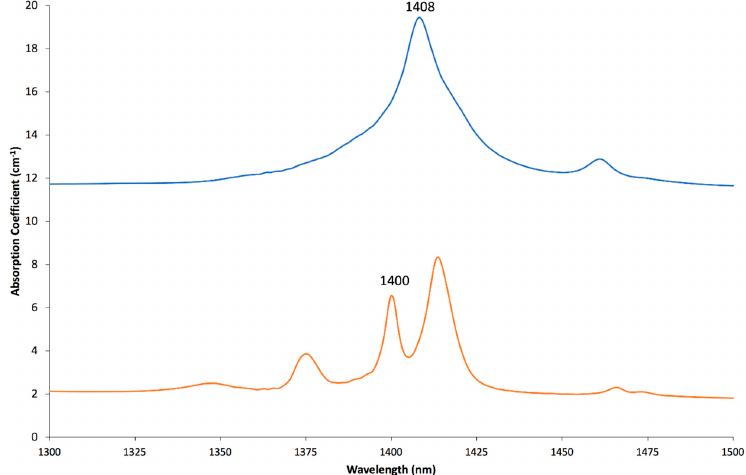
Figure 18. NIR polarized spectra of an emerald from Zambia. The light blue and orange lines are for the o-ray and e-ray spectra, respectively. The upper spectrum has been vertically offset for clarity. Thus, all emeralds from Type IA occurrences presented relatively important absorptions linked to Type II water; only the samples from Brazil, Russia and one (out of four) from Ethiopia showed